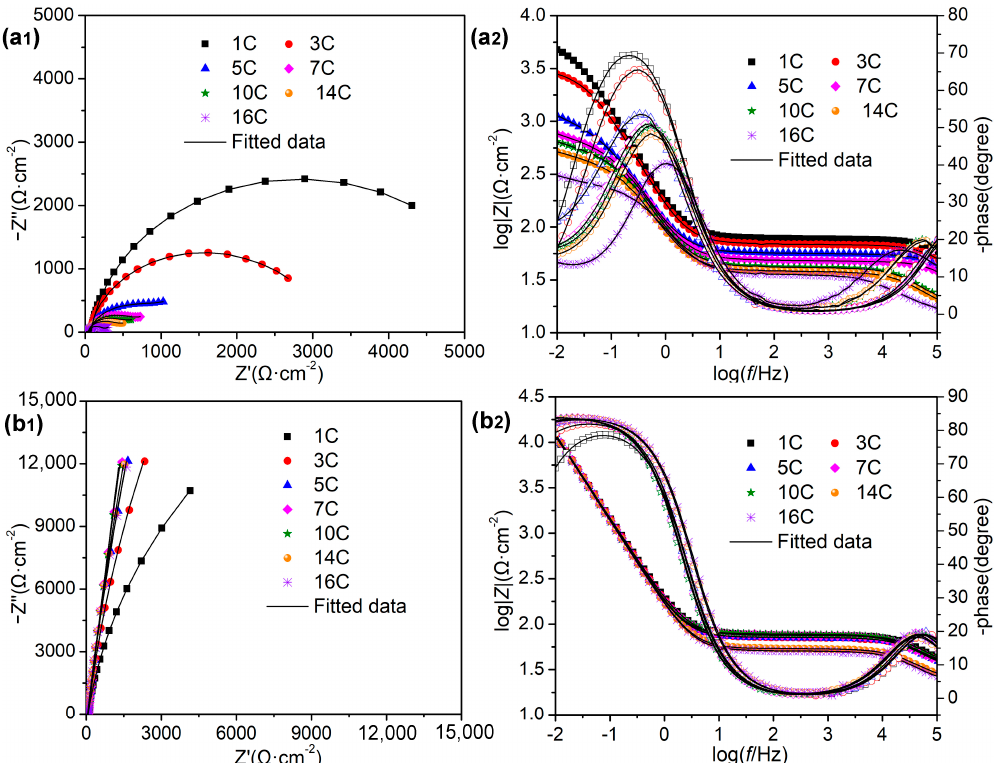
Figure 10. Nyquist ( left ) and Body ( right ) plots of the steel-mortar electrodes at different dry wet cyclic number immersed in 3.5 wt.% NaCl solution: ( a1 , a2 ) without LDH, ( b1 , b2 ) incorporated with 1 wt.% LDH − EG in the mortar.